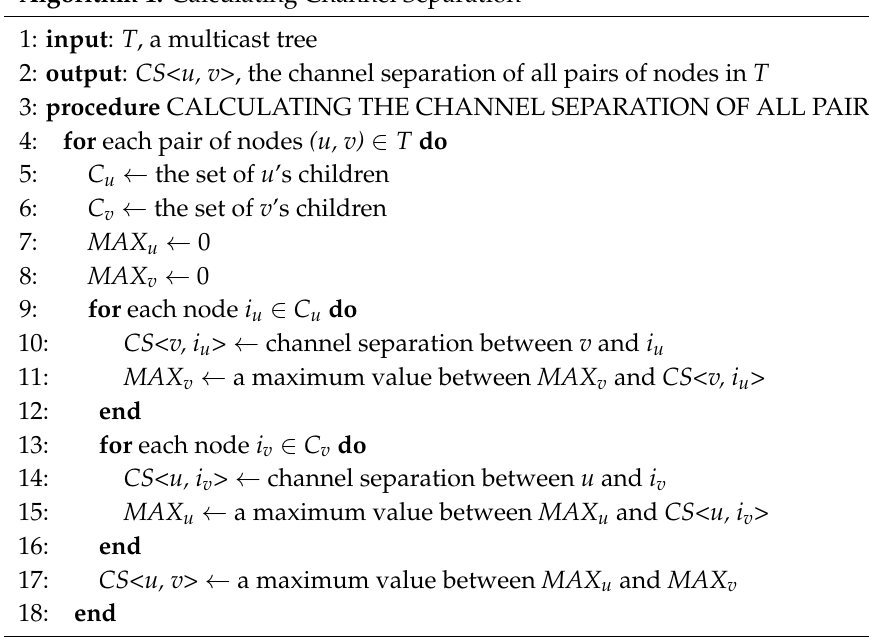
Algorithm 1: Calculating Channel